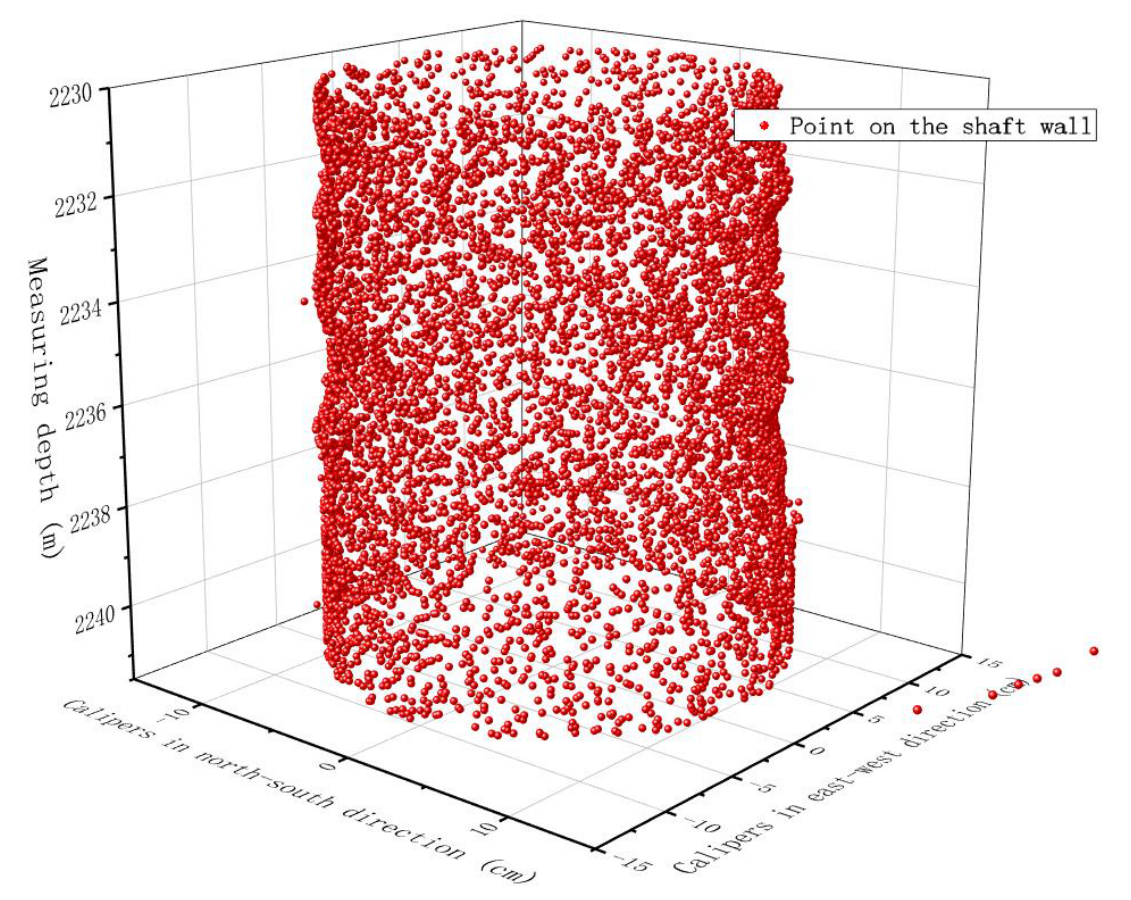
Figure 6. Caliper data obtained by scanning an open hole.